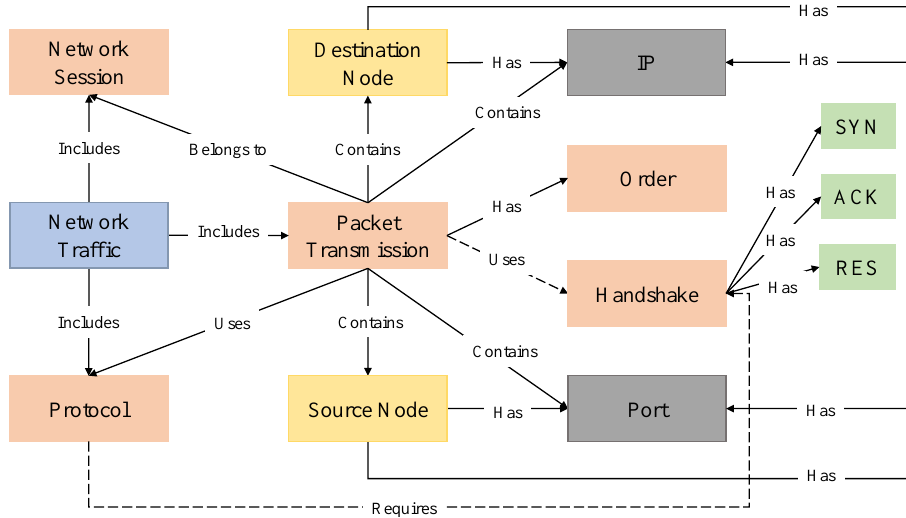
Figure 3. Diagram of NTO compositions and